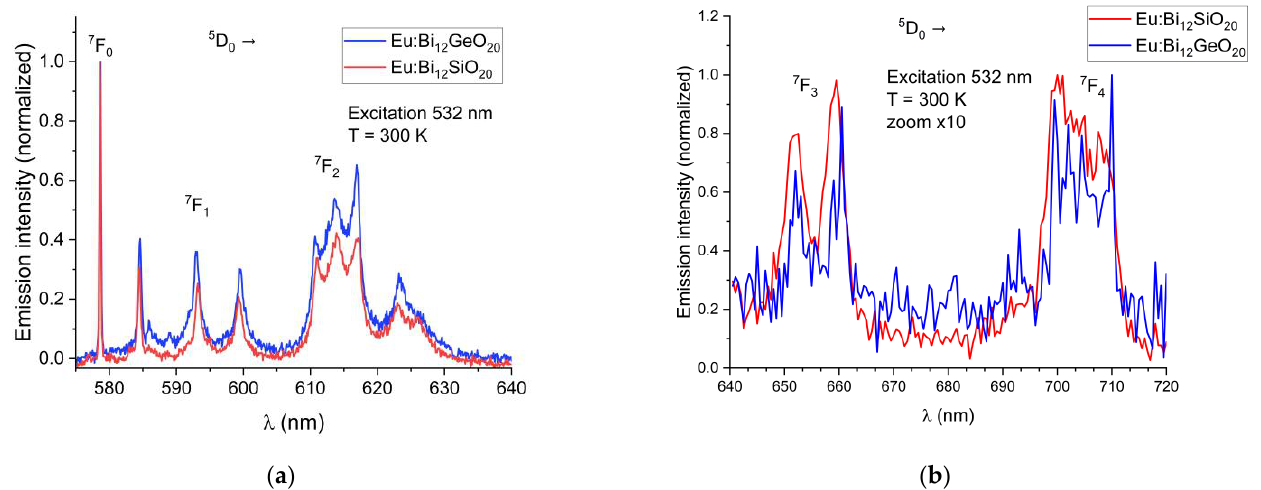
Figure 4. ( a ) Partial emission spectra of Eu 3+ showing the 5 D 0 → 7 F 0,1,2 transitions in BSO and BGO at T = 300 K; ( b ) Partial emission spectra of Eu 3+ showing the 5 D 0 → 7 F 3 and 5 D 0 → 7 F 4 transitions in BSO and BGO at T = 300 K (scaled for better visibility).